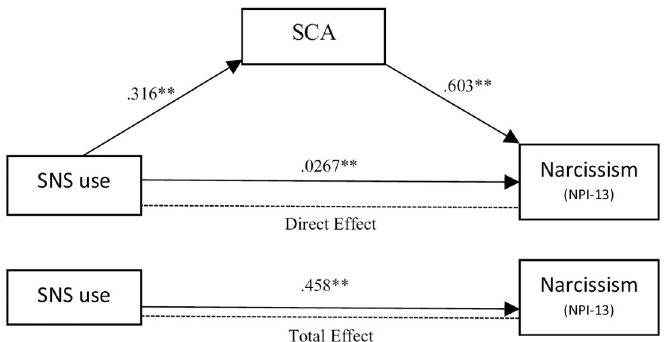
Fig 9. Mediation and total effect of the self-centered appearance focused use of social media (SCA) on the link between SNS and narcissism NPI-13.